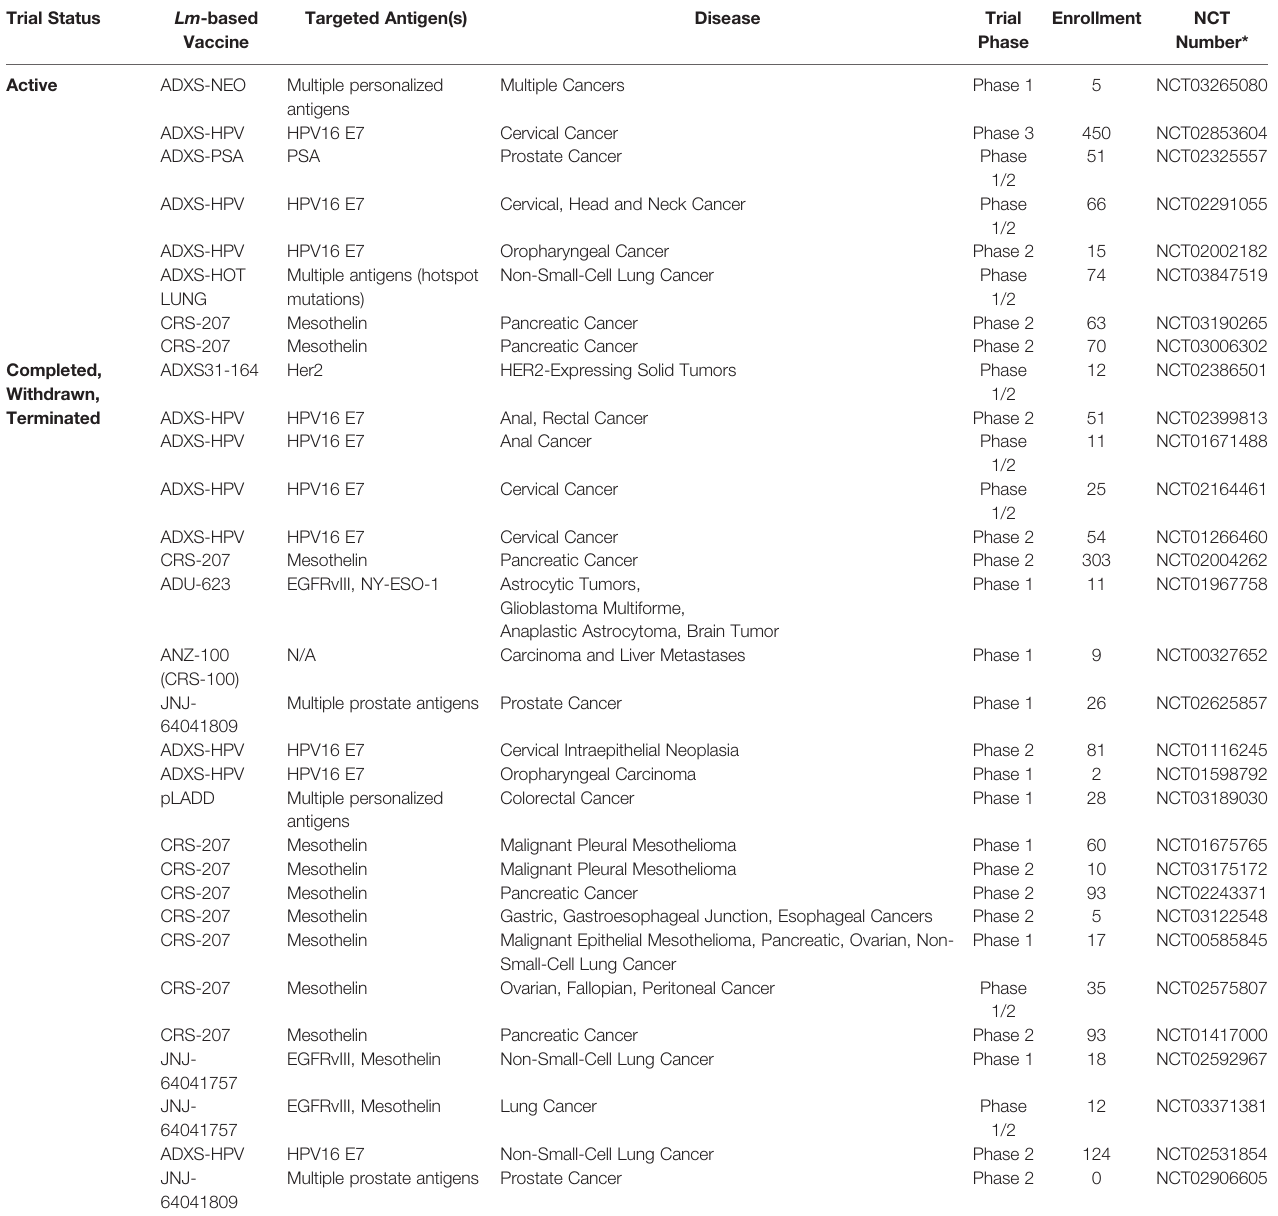
TABLE 1 | Clinical Trials for LC -based Vaccines in Tumor